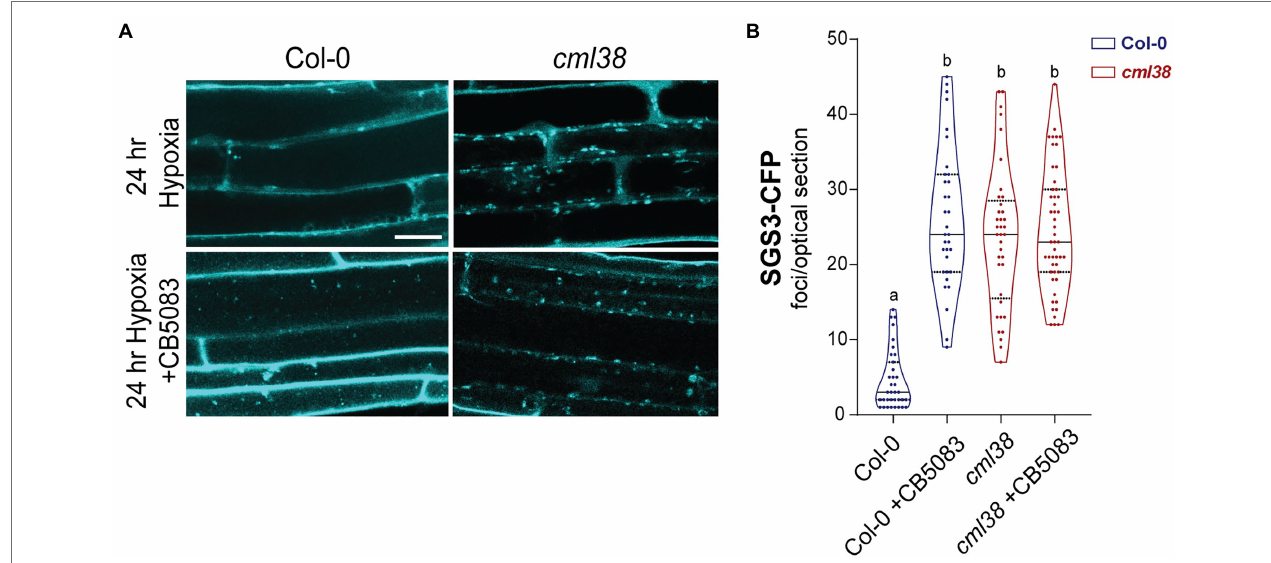
FIGURE 7 | CDC48 is required for the disappearance of SGS3-CFP bodies during extended hypoxia. (A) Representative epidermal cell images of 10-day old A. thaliana SGS3-CFP Col-0 and cml38 seedlings challenged with argon induced hypoxia for 24 h in the presence or absence of 2 μ M CB5083. All micrographs are the same scale, and the scale bar is 25 μ m. (B) Violin plot of SGS3-CFP foci quantitation of epidermal cells treated as described in (A) . Each data point represents a 2 μ m optical section from a single cell. Statistical significance was assessed by one-way